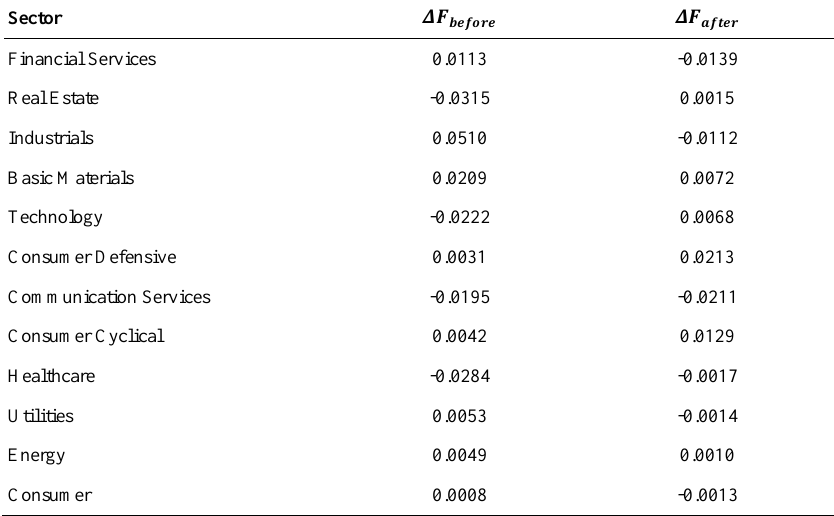
Table 7. The net information outflow for the sectors in KSE market, before and after COVID-19